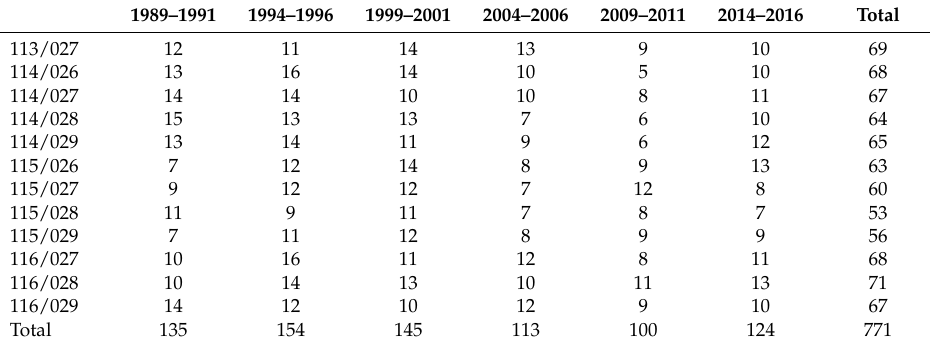
Table 2. Statistical information regarding the good-observations Landsat images for the path/row in each